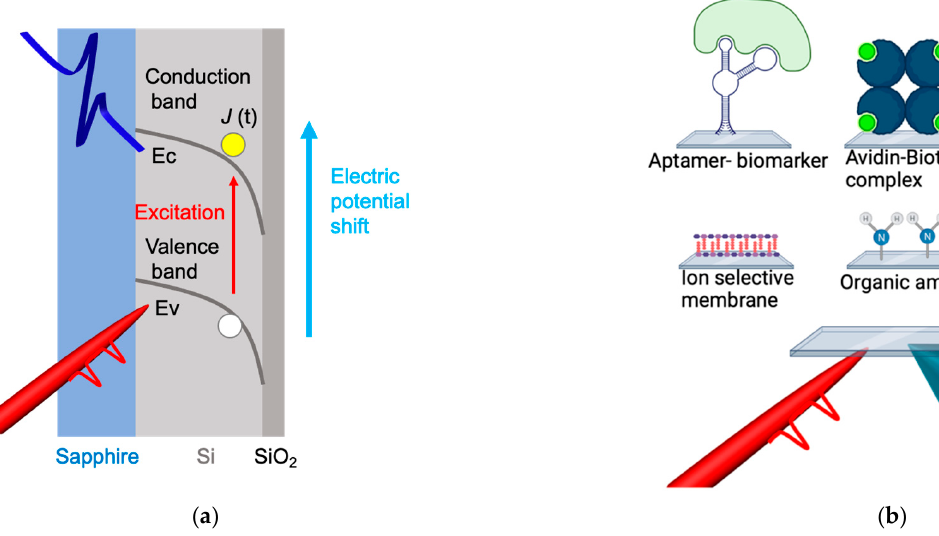
Figure 3. ( a ) Energy band diagram of the sensing plate. The sensing plate was made by forming a silicon thin film (Si film) on a sapphire substrate and then forming a silicon thermal oxide film (SiO 2 film). The film thicknesses of the Si film and the SiO 2 film are 150 nm and several nm, respectively. In the sensing plate, there are defects near the boundary between the Si and SiO2 films, so the energy band bends toward the boundary surface and a depletion layer electric field is generated. The electrical or chemical reaction on the sensing plate surface could shift the electric potential, it simultaneously changes the magnitude of the depletion field. ( b ) Chemical modification and bio-modification on the sensing plate are applied for chemical or bio-related substances detection and evaluation. Created with BioRender.com.